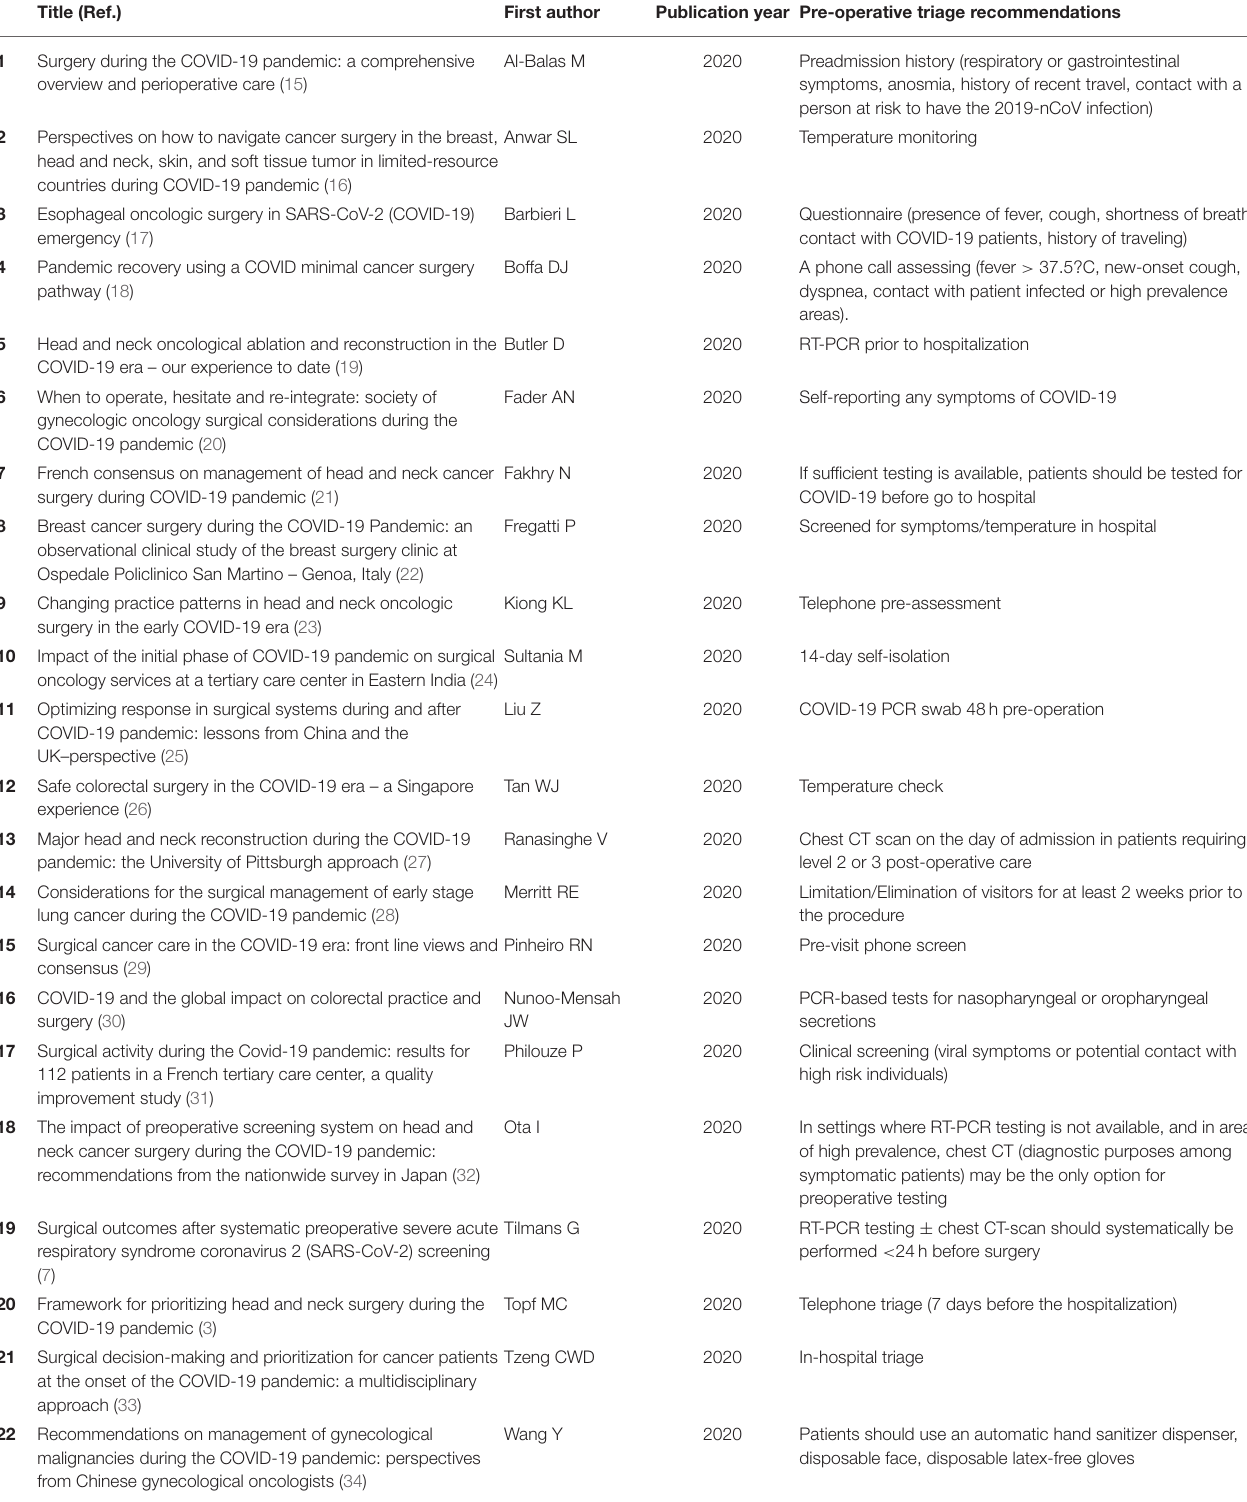
TABLE 1 | The characteristics and the preoperative triage recommendations of the included